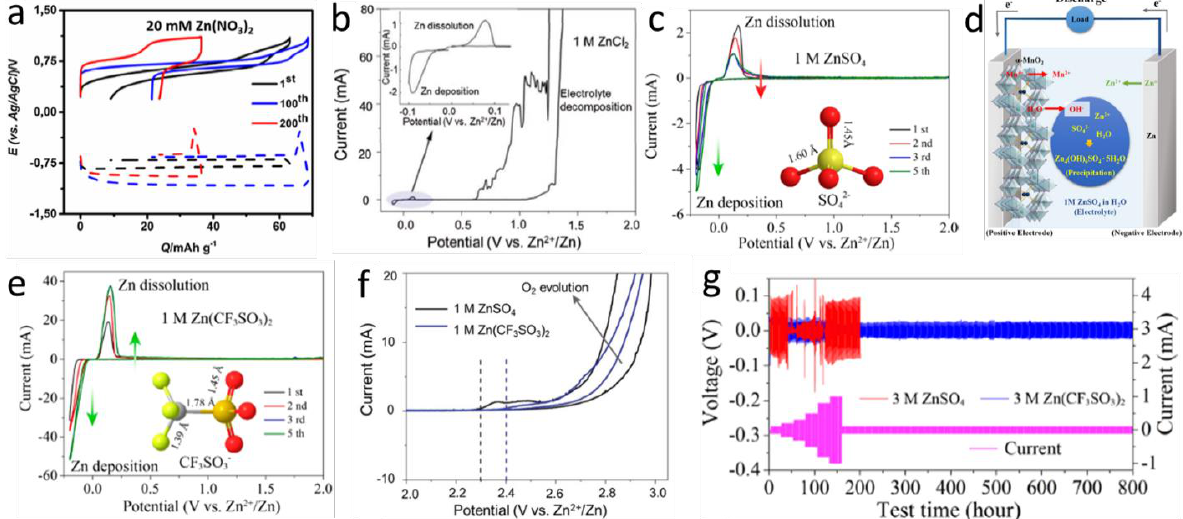
Figure 12. ( a ) Zn/Zn(NO 3 ) 2 /CuHCF battery potential profile at 1 C current rate. (Reproduced with permission. [133] Copyright 2016, Elsevier). Cyclic voltammograms of Zn electrode in aqueous electrolyte of ( b ) 1 M ZnCl 2 and ( c ) 1 M ZnSO 4 at the scan rate of 0.5 mV s – 1 between −0.2 and 2.0 V (Reproduced with permission. [134] Copyright 2016, American Chemical Society). ( d ) Illustration of reactions that occur in α -MnO 2 /Zn cells employing aqueous ZnSO 4 electrolytes during discharge process. (Reproduced with permission. [138] Copyright 2016, John Wiley & Son). ( e ) Cyclic voltammogram of Zn electrode in aqueous electrolyte of 1 M Zn(CF 3 SO 3 ) 2 . ( f ) Electrochemical stability of ZIBs using ZnSO 4 or Zn(CF 3 SO 3 ) 2 . ( g ) Long-term cyclability of Zn/Zn symmetrical cells in ZnSO 4 and Zn(CF 3 SO 3 ) 2 electrolytes (Reproduced with permission. [134] Copyright 2016, American Chemical Society).